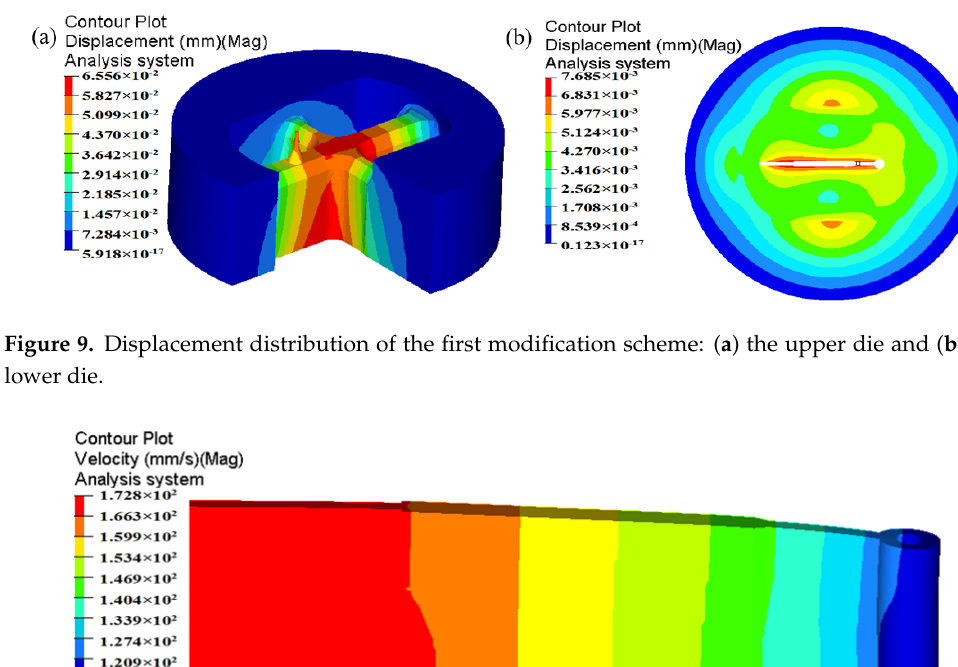
Figure 8. Geometric model of porthole die for the first modification scheme.